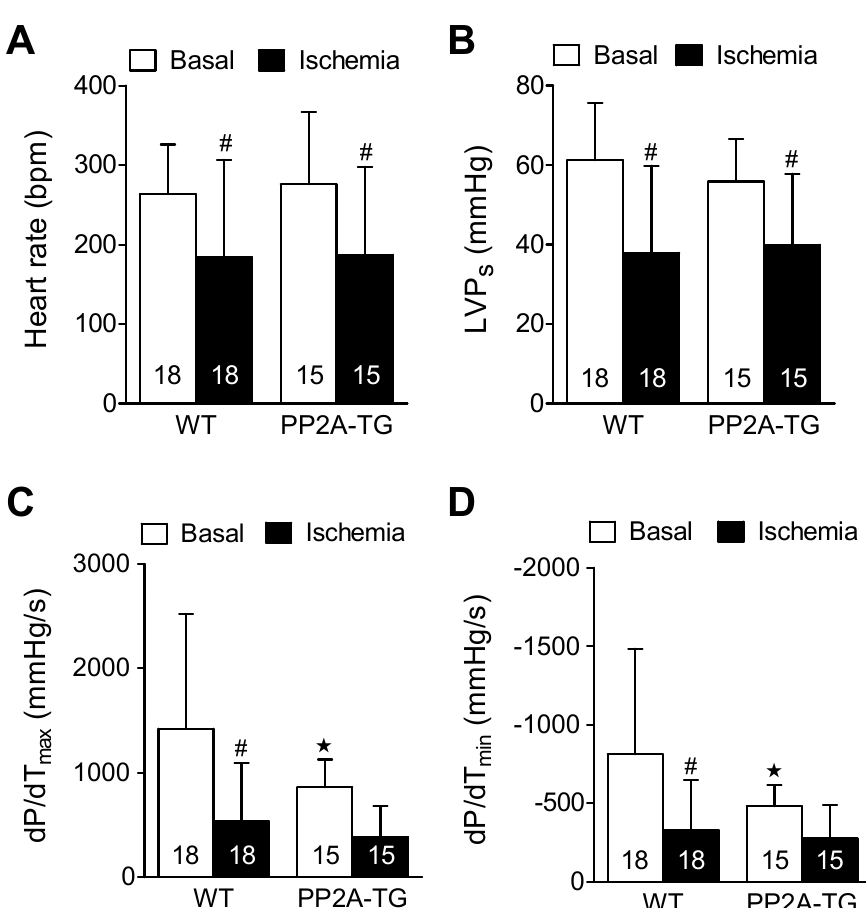
Figure 6. Ischemic cardiac function in isolated perfused hearts from wild type hearts (WT) and heart with cardiac specific overexpression of the catalytic subunit of protein phosphatase 2A (PP2A-TG). Contraction parameters were assessed under basal conditions and 120 min after ischemia. Heart rate is depicted as beats per minute (BPM) under ( A ), maximum left ventricular pressure as milli meter mercury column (mm Hg) ( B ) as LVPs, maximum first derivative of pressure in left ventricle in millimeter mercury column per second (mmHg/s) in the ordinate of ( C ), minimum first derivative of pressure in left ventricle in millimeter mercury column per second (mmHg/s) in the ordinate of ( D ), open bars indicated basal perfusion conditions and filled bars indicate values at the end of the ischemia. Numbers in bars depict the numbers of experiments in hearts from WT or PP2A-TG. ★ p < 0.05 vs. WT, # p < 0.05 vs. basal conditions.